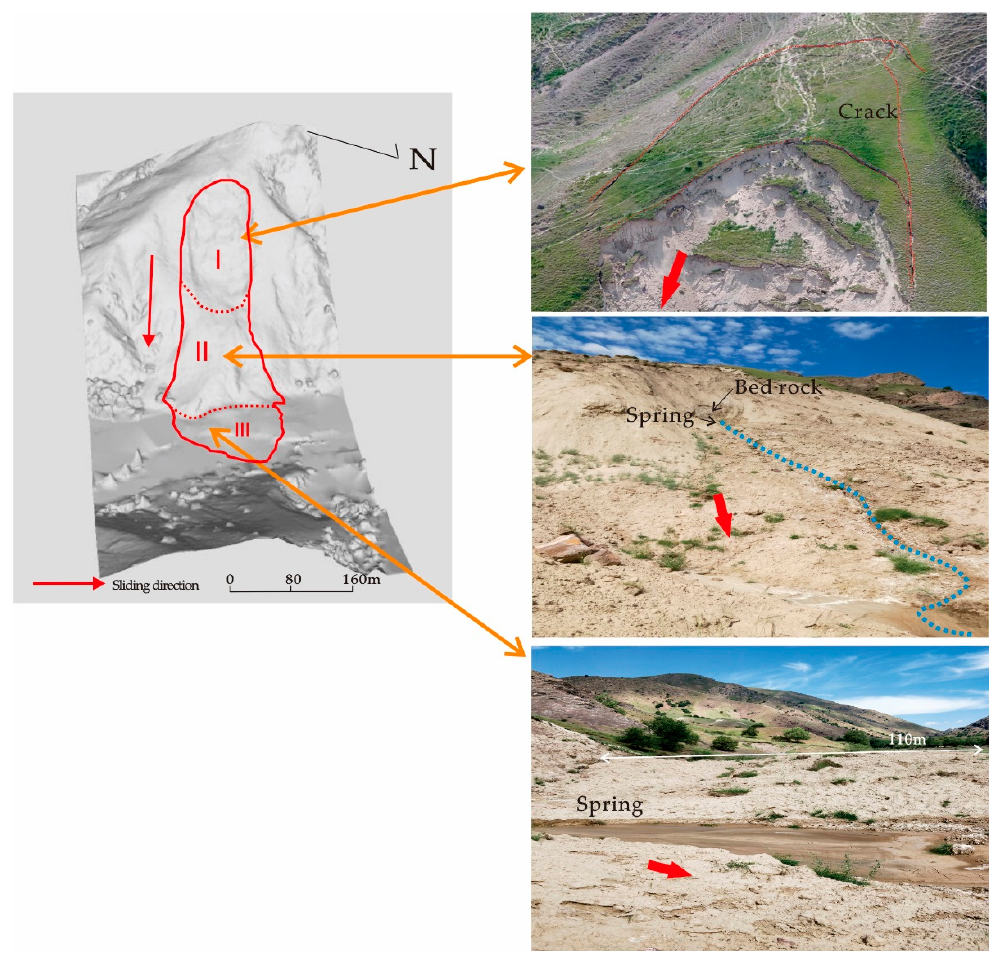
Figure 5. Three-dimensional Digital Elevation Model diagram of the landslide and typical pictures.